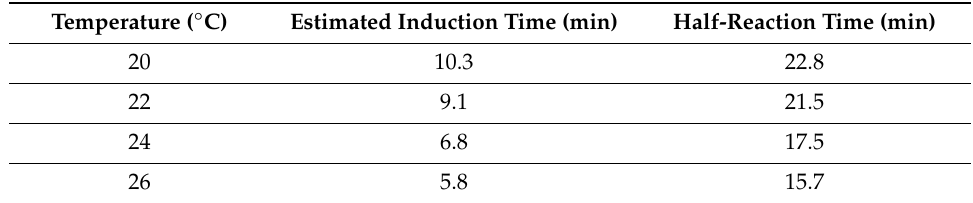
Table 1. Correlation between the reaction mixture’s temperature ( ± 0.5 ◦ C) and the rate of the gypsum precipitation